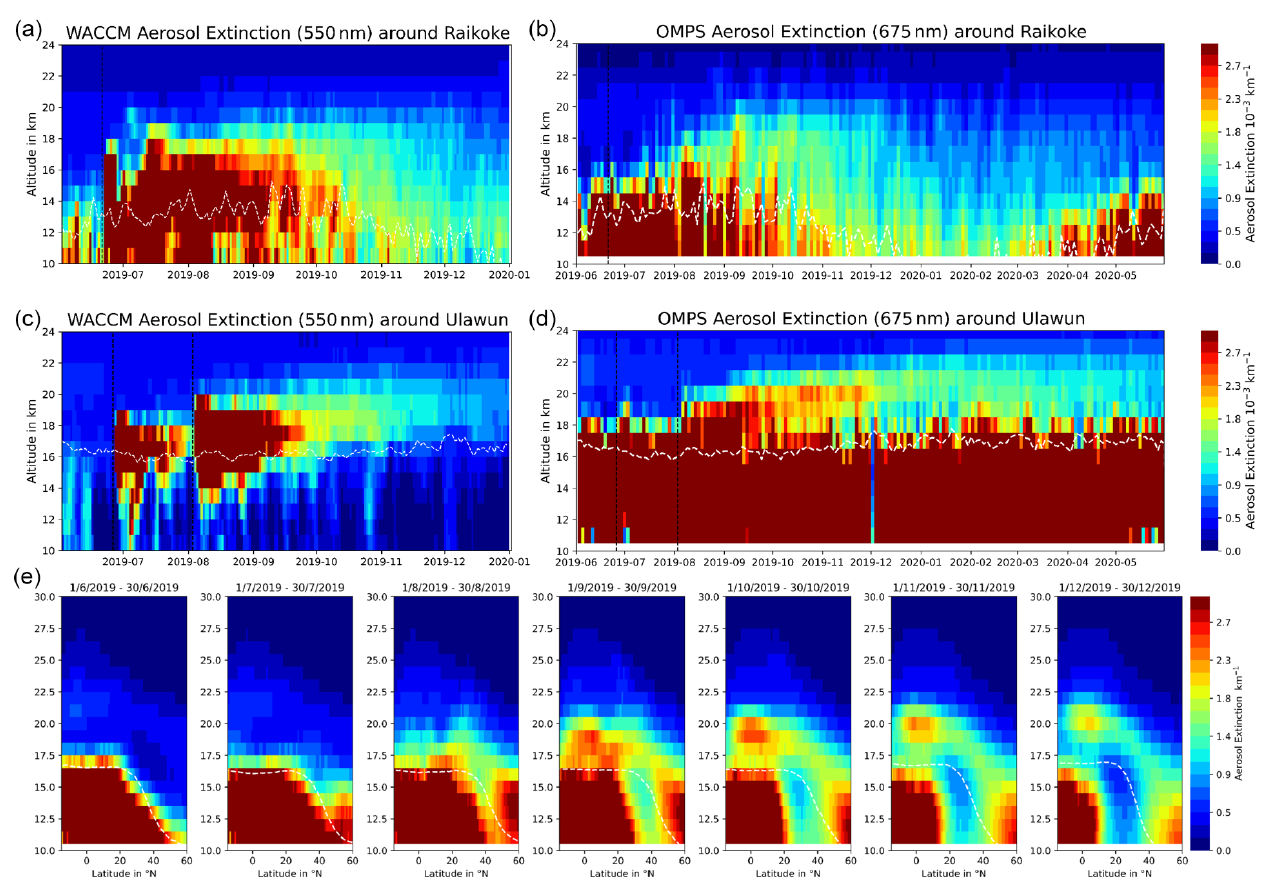
Figure 7. Vertical aerosol extinction distribution at the location of the volcanoes. (a) WACCM simulation around the Raikoke location (30–55 ◦ N and 145–175 ◦ E) and (b) OMPS observations, respectively. (c) and (d) , respectively, for the Ulawun eruption (0–10 ◦ S and 145– 175 ◦ E). The timing of the Raikoke and both Ulawun eruptions is indicated by the black, dashed lines. (e) OMPS aerosol extinction monthly averages over all longitudes from June to December 2019. White dashed lines represent the averaged tropopause